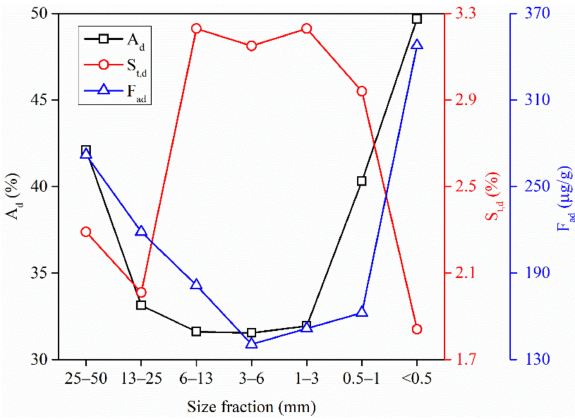
Figure 1. The ash content, total sulfur content, and fluorine content of different size fractions.